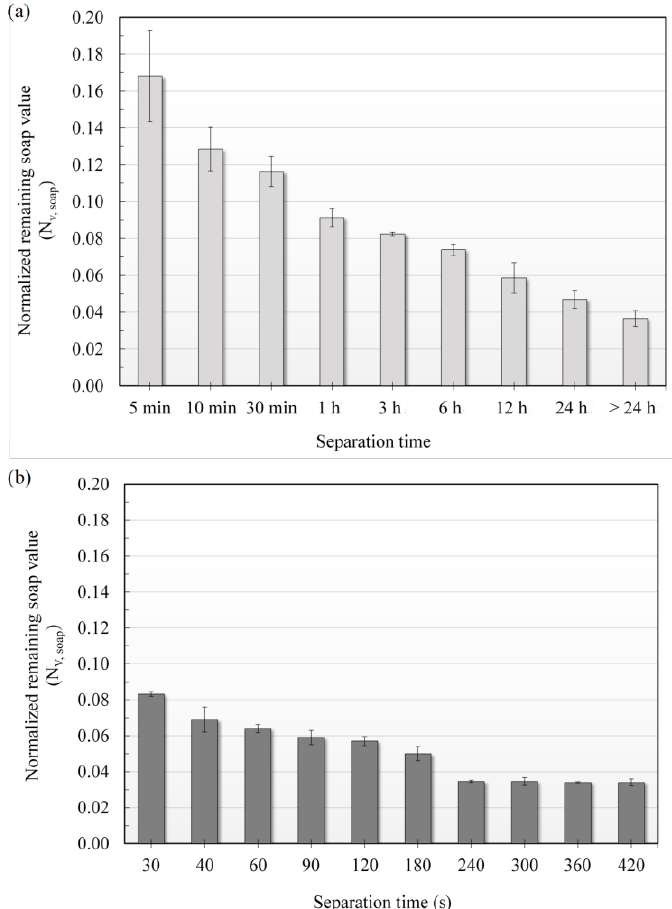
Figure 16. Normalized concentrations of remaining soap in the biodiesel final product from the EDS process using iron (Fe) point-to-point electrodes, with a vertical distance between electrodes of 3 cm and applied AC voltage of 3 kV: ( a ) gravitational settling (GS) and ( b ) electrically driven separation (EDS) process.